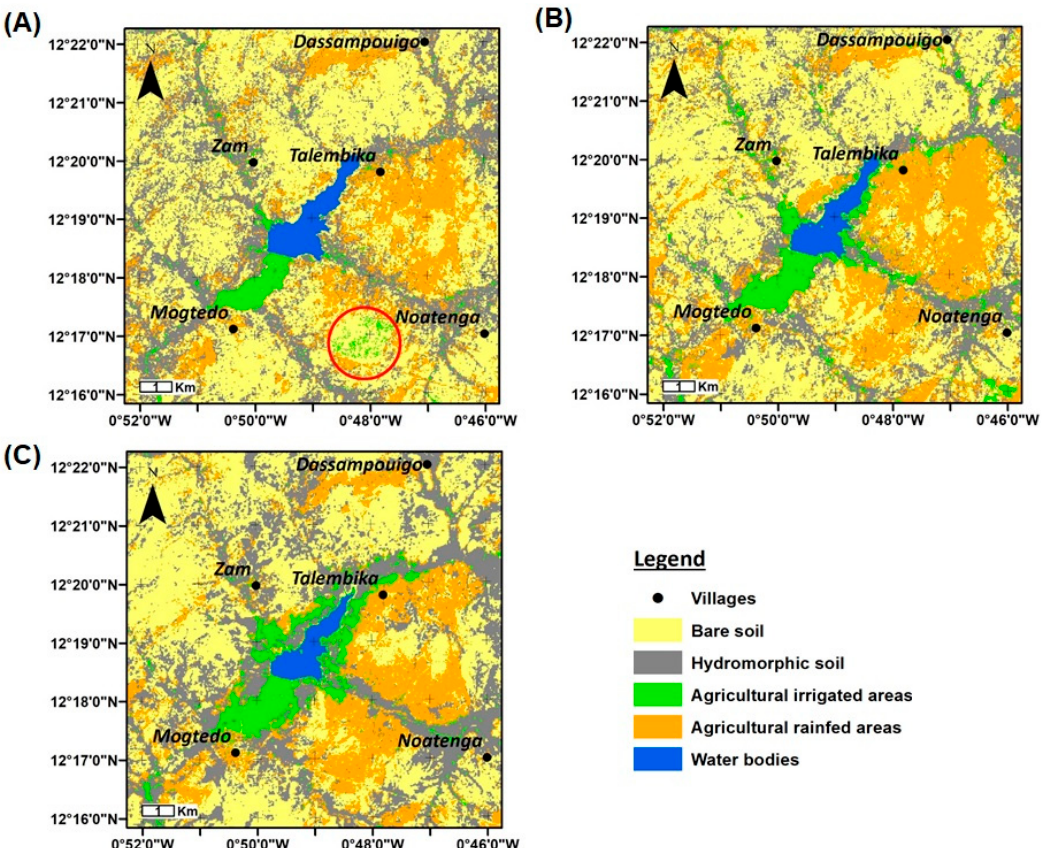
Figure 4. Initial classification of the different satellite images. ( A ) Landsat-5 TM image (15 February 1987); ( B ) Landsat-7 ETM+ image (11 February 2000); ( C ) Landsat-8 OLI image (27 January 2015).